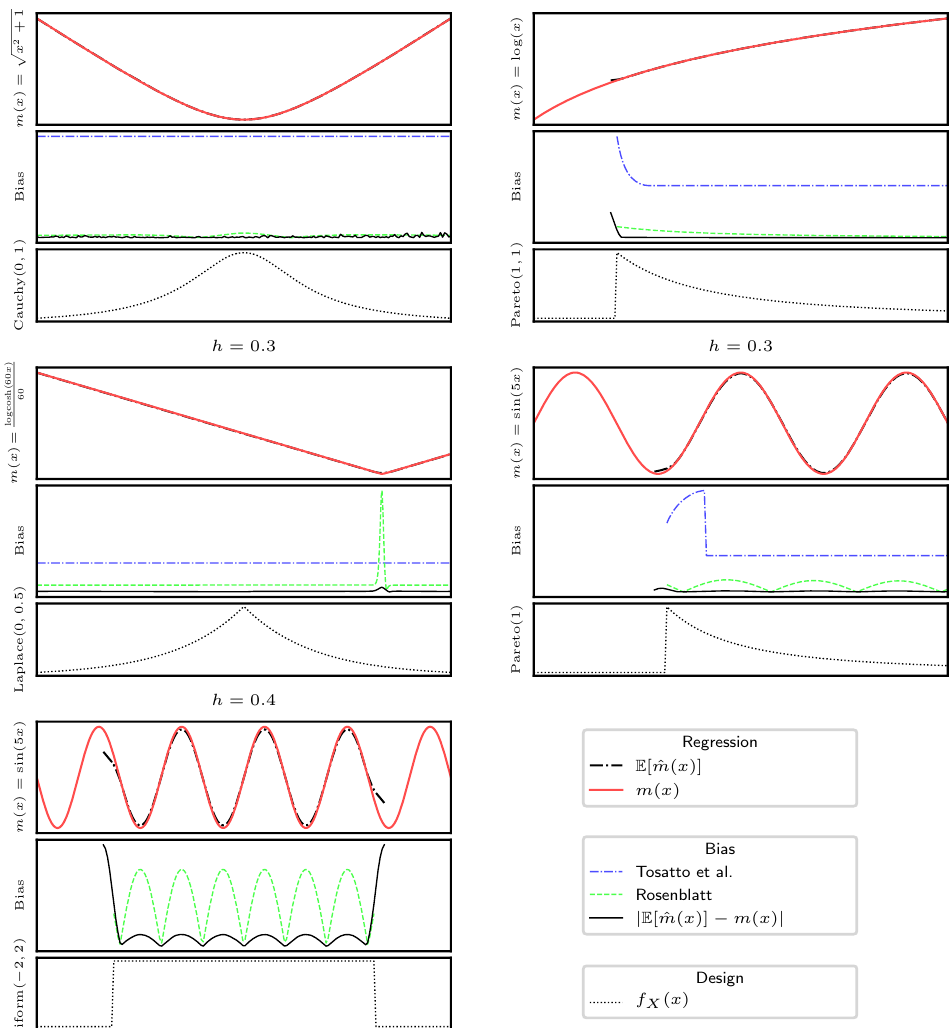
Figure A3. Same experiment as in Figure 1, with Triangular Kernel. Note that this particular kernel, does not have finite bound for L f =